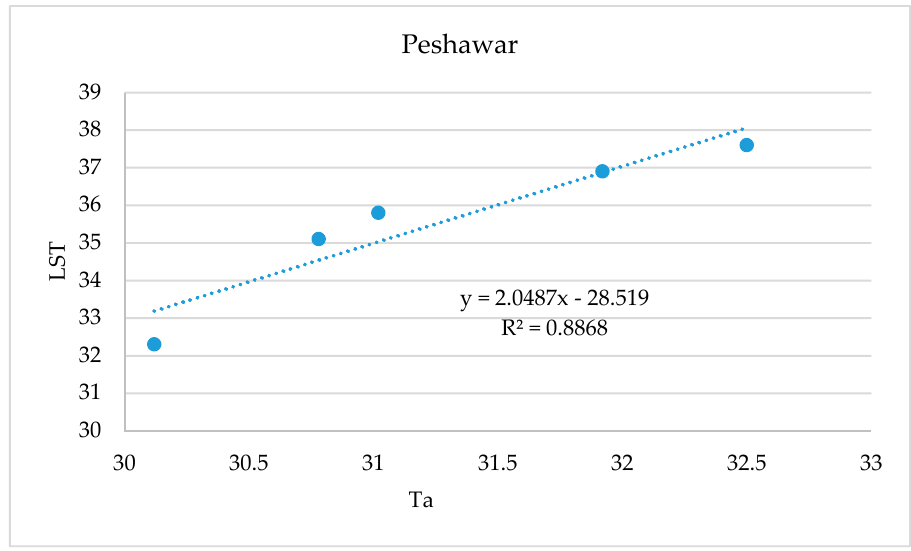
Figure 8. Scatterplot of LST versus Ta (3 months average (May–July) for Lahore city.